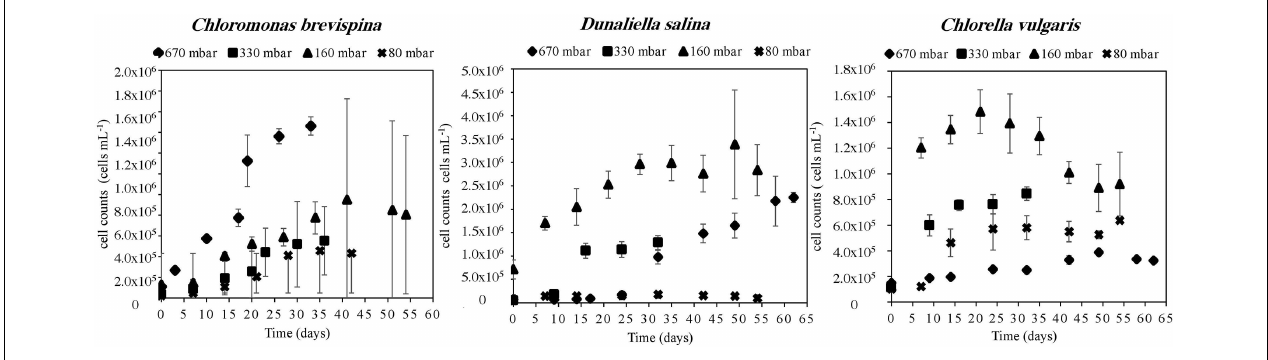
FIGURE 3 | Growth curves of Chloromonas brevispina (CB), Chlorella vulgaris (CV), and Dunaliella salina (DS) at pressures of 670 ± 20 mbar, 330 ± 20 mbar, 160 ± 20 mbar, and 80 ± 2.5 mbar plotted as a mean value ( n = 4) of duplicate cell count measurements of duplicate experiments. Error bars are 1 standard deviation of mean cell count values, and all data are shown in Supplementary Tables 1–3 . Where error bars are not shown they lie within the